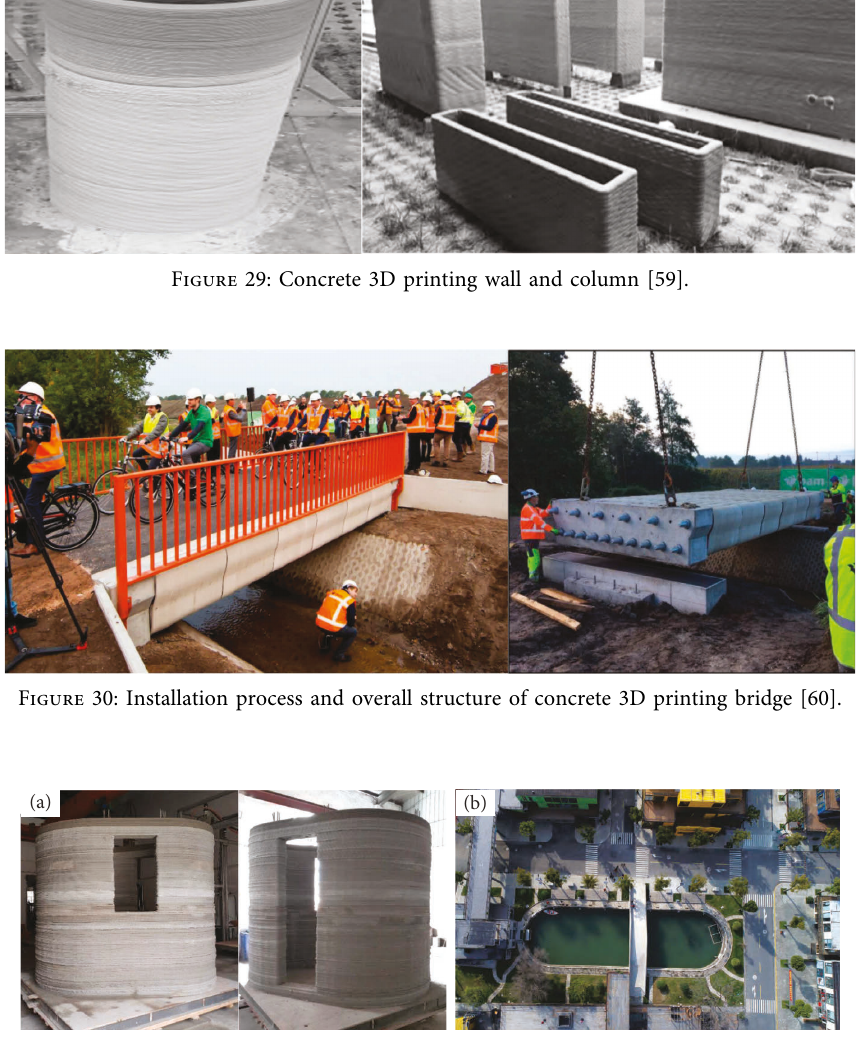
Figure 31: Concrete 3D printing room (a) [62] and concrete 3D printing walking bridge (b)